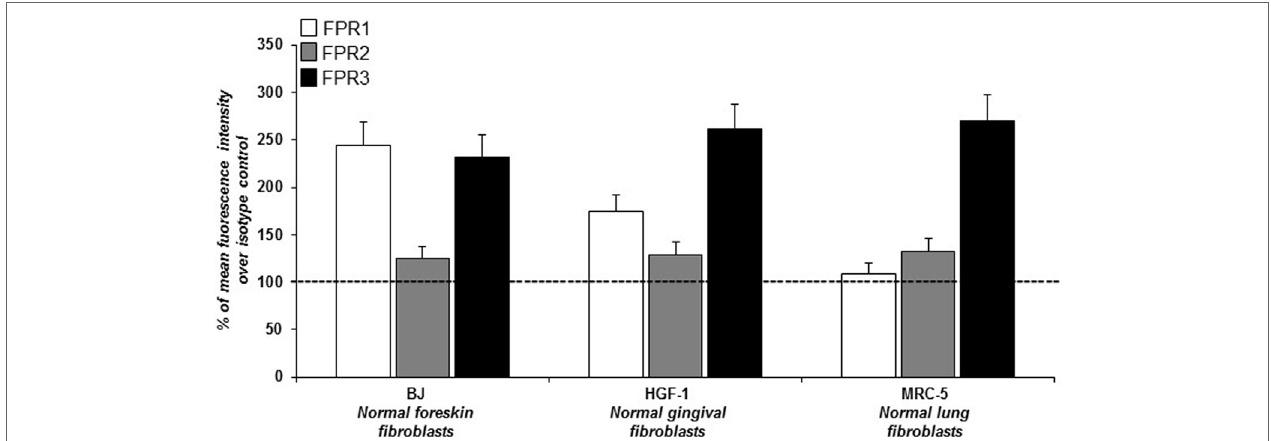
FigUre 1 | Cytofluorimetric analysis of N -formyl peptide receptors (FPRs) expression in human normal fibroblasts. Mean fluorescence intensity of FPR1 (white column), FPR2 (gray column), and FPR3 (black column) expression in BJ (human normal foreskin fibroblasts), HGF-1 (human normal gingival fibroblasts) and MRC-5 (human normal lung fibroblasts) cell lines expressed as a percentage of increase of mean fluorescence intensity of antibody-treated cells over mean fluorescence intensity of isotype control treated cells (considered as